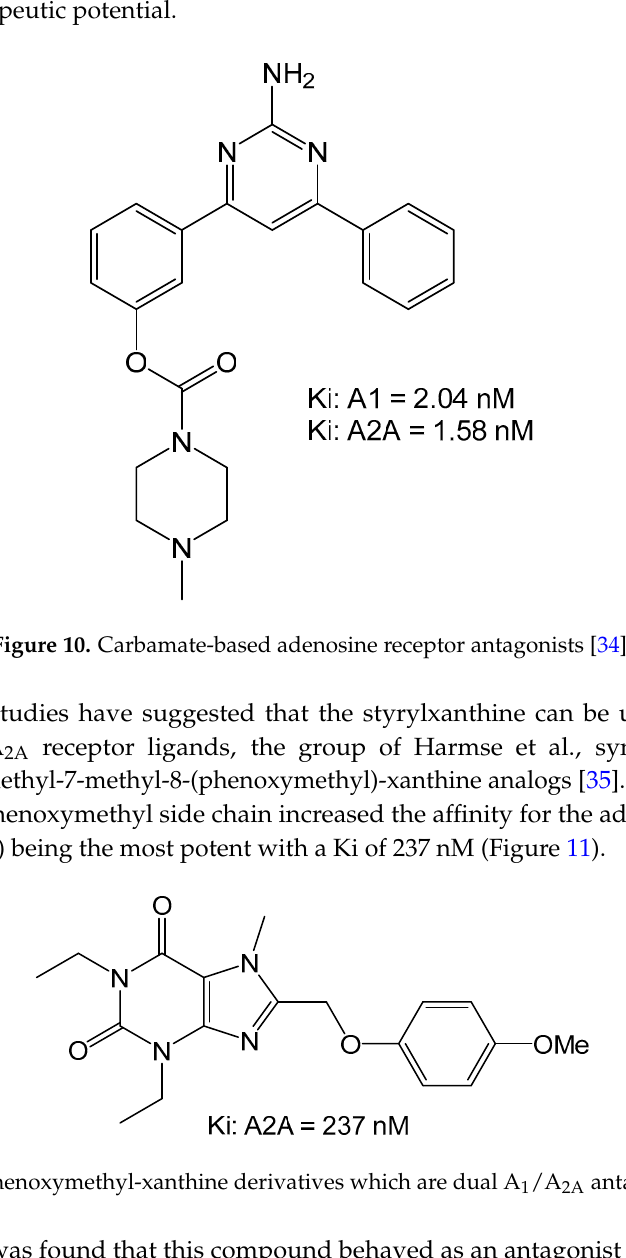
1 /A 2A antagonists